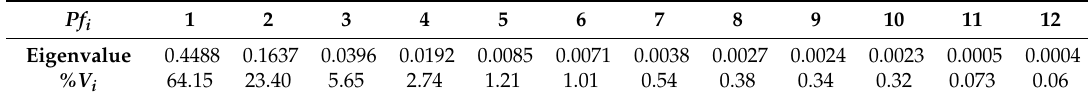
Table 1. Eigenvalues and % V i of the forward BRMT for P 1 – P 12 for the selected subset of the study